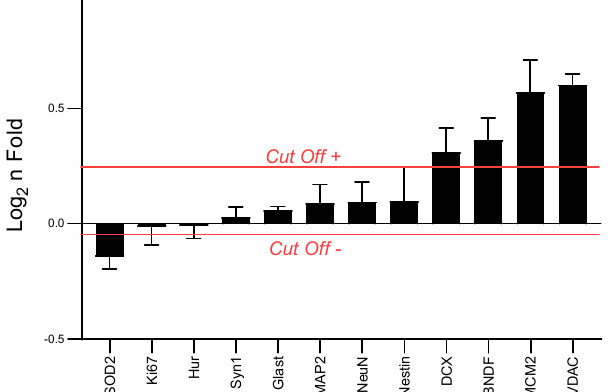
Figure 2. E ff ects of one-week HIIT on neuronal plasticity in the hippocampus. Proliferative and growth stem cell related proteins: Ki67, minichromosome maintenance complex componente 2 (MCM2), Nestin, Hu-antigen R (HuR), and sodium-dependent glutamate / aspartate transporter 1 (GLAST). Immature neurons and neurogenesis related proteins: doublecortin (DCX). Mature neuron related protein: neuronal nuclei (NeuN); Neuritogenesis related protein: microtubule-associated protein 2 (MAP2). Survival and neurogenesis: brain derived neutrophic factor (BDNF). Synaptogenesis related protein: synapsin-1 (Syn1). Mitochondrial transporter and mitochondria content marker: voltage-dependent anion-selective channel protein 2 (VDAC). Mitochondrial antioxidant enzyme: superoxide dismutase 2, mitochondrial (SOD